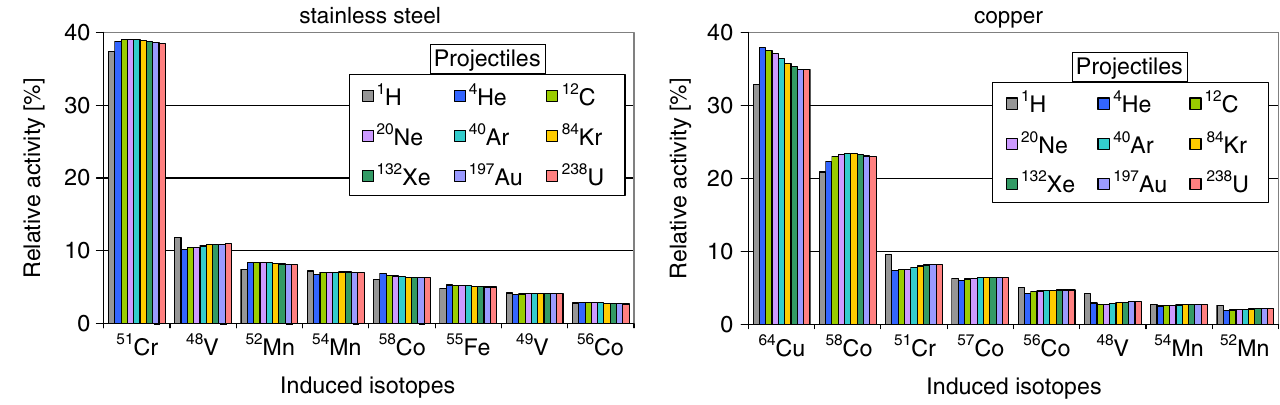
FIG. 9. (Color) Isotope inventory and their relative activities 1 day after the end of irradiation induced by 1 GeV = u projectiles from proton up to uranium in stainless steel and copper bulky target. Relative standard uncertainty of the calculated activity of individual isotopes ranged from 0.12% (high-activity isotopes) to 1.24% (low-activity